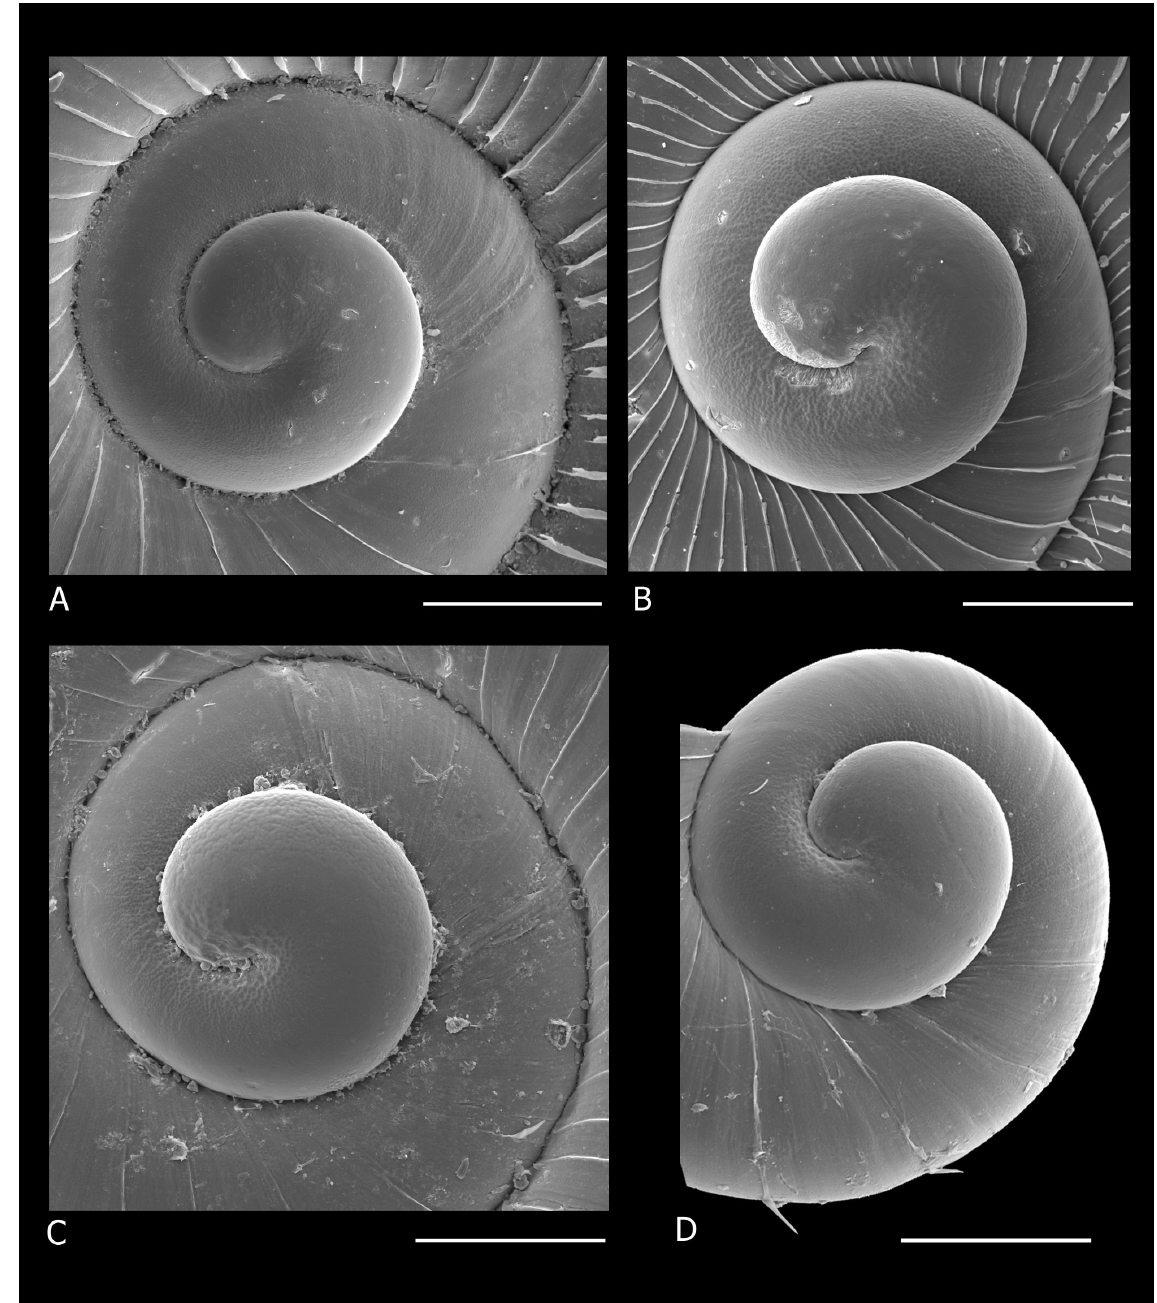
Fig. 28. Protoconch detail of species of Afrocyclus gen. nov. A . Afrocyclus isipingoensis (Sturany, 1898) gen. et comb. nov. from Durban (near type locality) (ELM W3648). B . A. oxygala gen. et sp. nov. (ELM W3647). C . A. potteri gen. et sp. nov. (ELM W4052). D . A. bhaca gen. et sp. nov. (NMSA V4889). Scale bars: A–D = 200